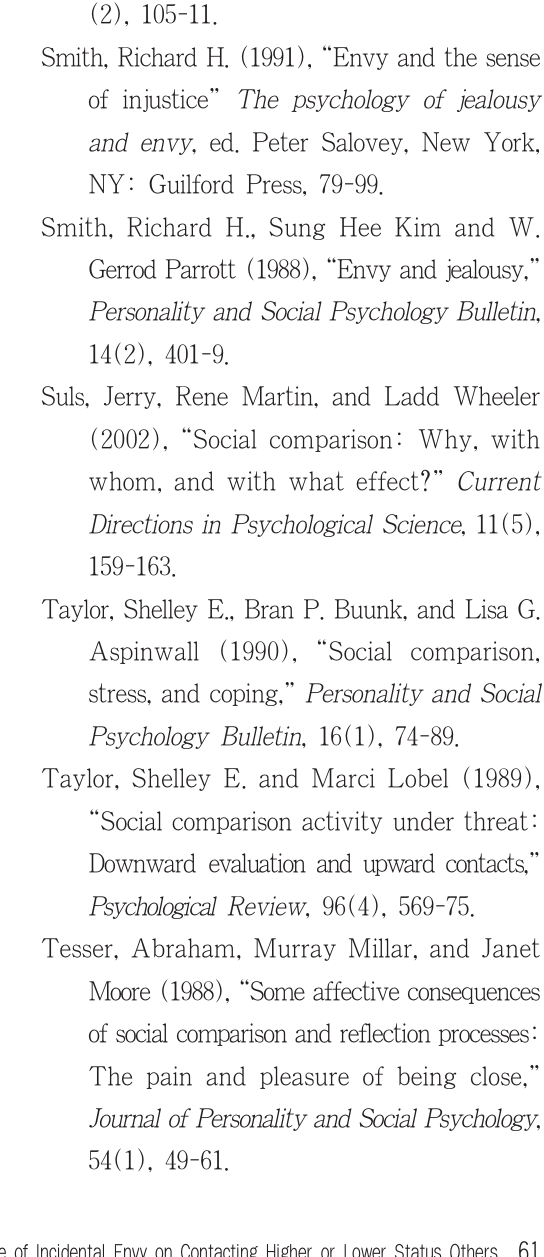
Social Comparison Theory and Interpersonal Contact: The Influence of Incidental Envy on Contacting Higher or Lower Status Others